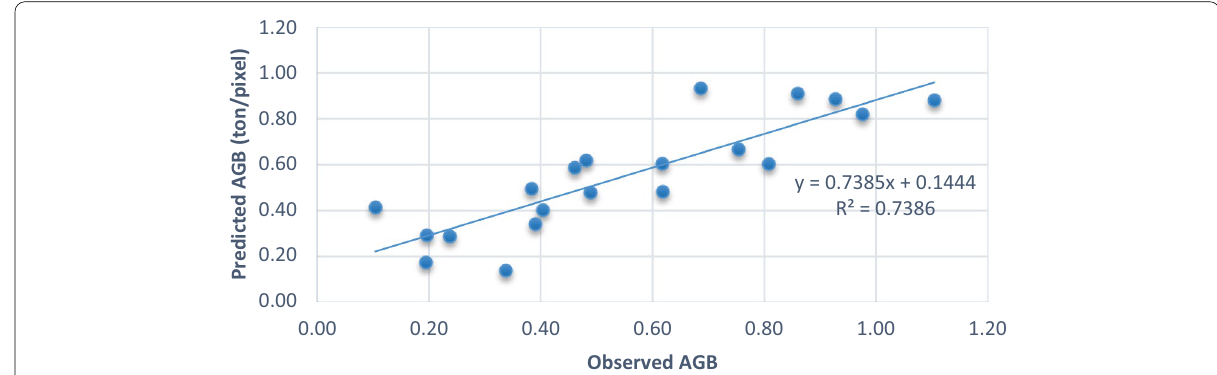
Fig. 10 Scatter plot showing goodness of fit between the observed and predicted values of the above-ground biomass